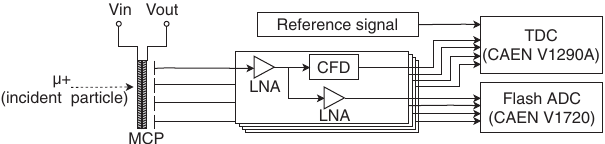
FIG. 2. Schematic diagram of the BWM. LNA stands for low- noise amplifier.